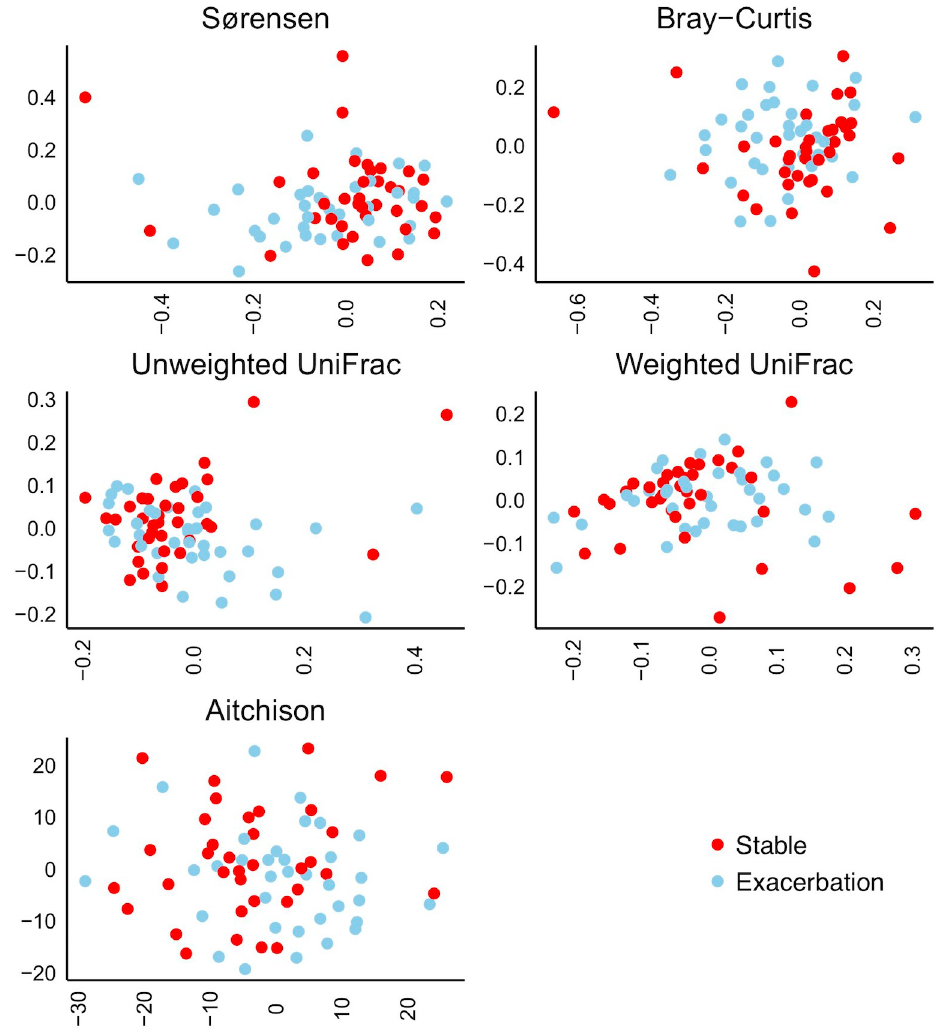
Fig 7. Beta-diversity in induced sputum collected from 36 chronic obstructive pulmonary disease sufferers both at stable state and during exacerbations, presented with non-metric multidimensional scaling (NMDS) ordinations. The X- and Y-axes display the first and second NMDS dimension respectively. Distance matrices: S ø rensen and Bray Curtis: Both non-phylogenetic; qualitative and quantitative information respectively. Unweighted and weighted UniFrac: Both phylogenetic; qualitative and quantitative information respectively. Aitchison: Compositional interpretation of sequence counts.